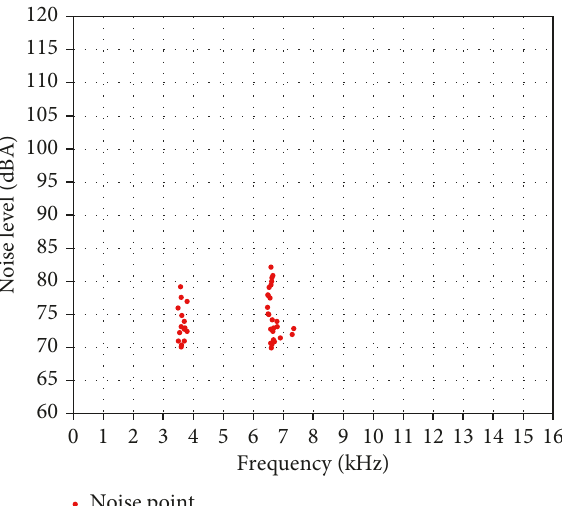
Table 7. The frequency changes of the Sample 3 are